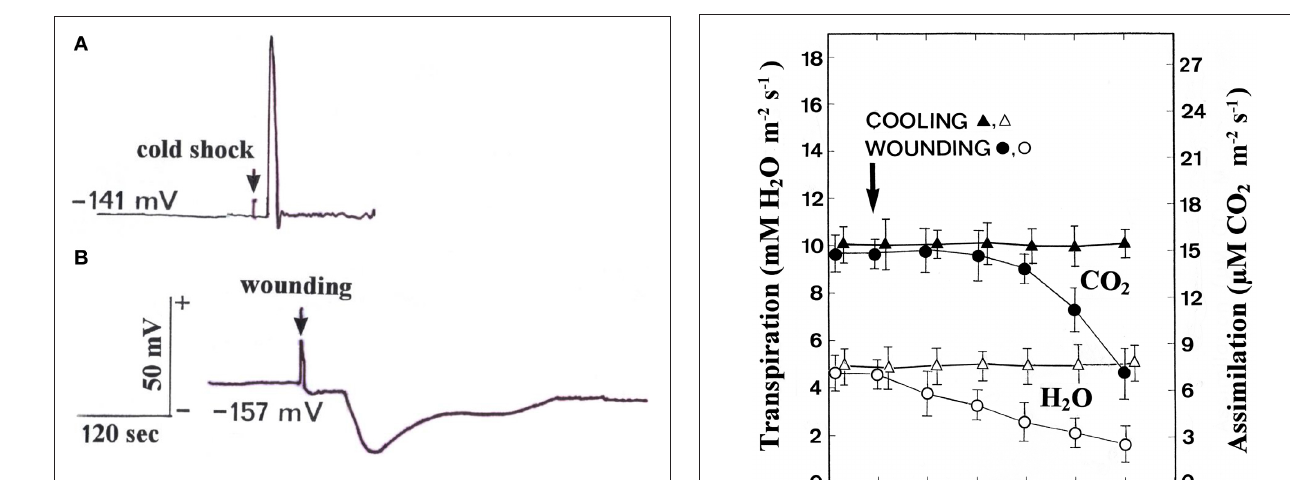
FIGURE 1 | Electrical signals measured with the aphid stylet technique in a sieve element after stimulation of the leaf tip at a distance of 10cm. (A) Stimulation of the tip by water ice triggered an action potential travelling with a speed of 3cm s − 1 in a basipetal direction. (B) Wounding by cutting the tip induced a variation potential propagating basipetally at a speed of 0.5cm s − 1 . (Typical signal time courses out of a total of five measurements).